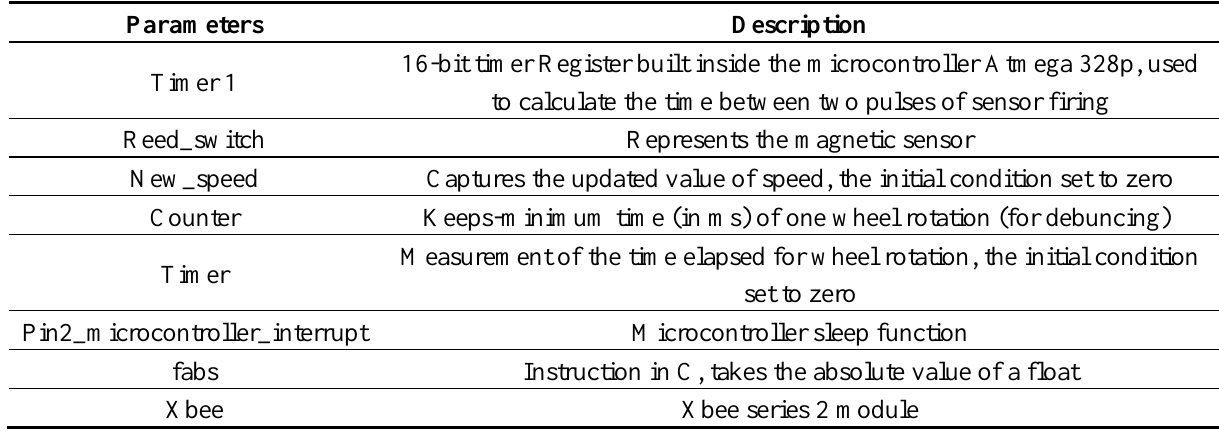
Table 2. The definition of the parameters in RCD